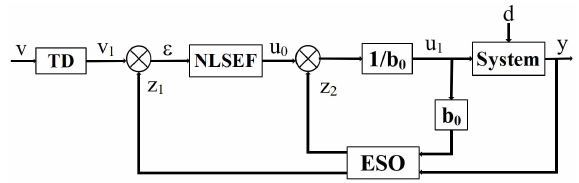
Figure 2. Schematic diagram of standard ADRC